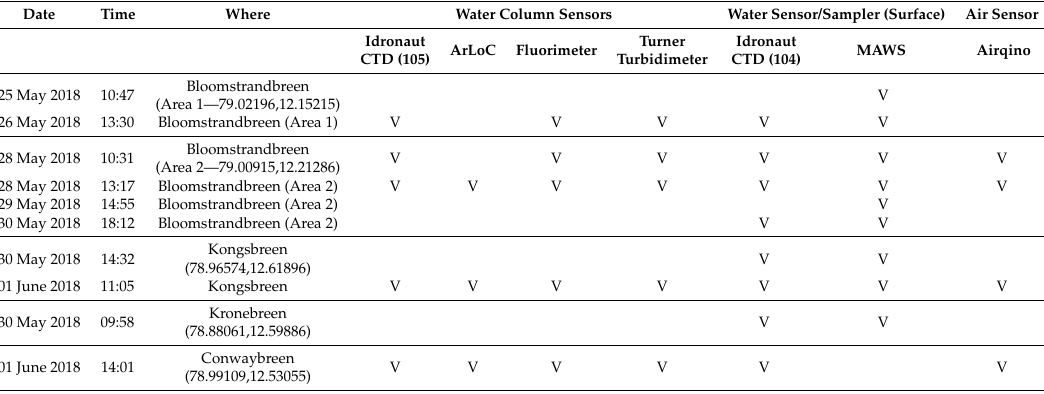
Table 3. EXCELLABUST project: Missions performed in Kongsfjorden by PROTEUS enhanced